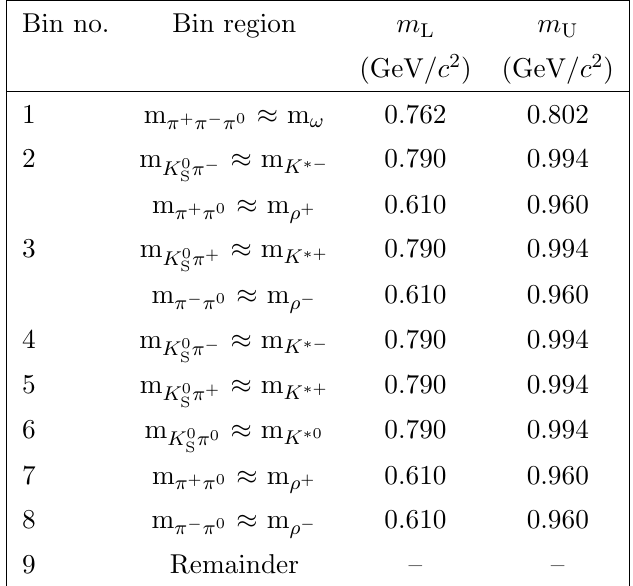
Table 1 . Speci(cid:12)cations of the nine exclusive bins of D ! K 0 m U are the lower and upper limit, respectively, of the invariant mass in each region [13].